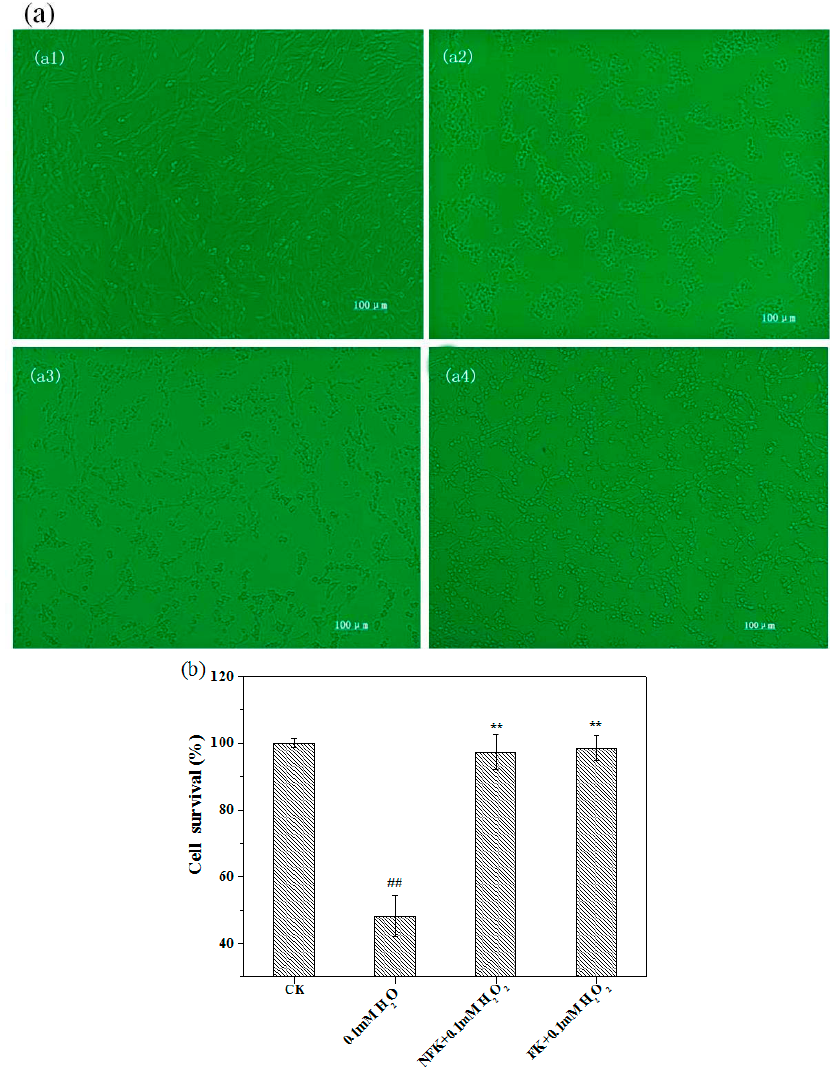
Figure 2. Effects of NFK and FK on PC12 cell damaged by 0.1 mM H 2 O 2 . ( a ) Cell microscope observed under an inverted microscope, ( a1 ) CK; ( a2 ) damage group; and ( a3 , a4 ) sample group (scale: 100 µm); ( b ) Cytotoxicity of NFK (10 mg/mL) and FK (10 mg/mL) on PC12 cells. Data are presented as mean ± S.D. ( n = 3). ## p < 0.01 indicates significant differ between the control group and damage group, ** p < 0.01 indicates significant difference between sample group and damage group.